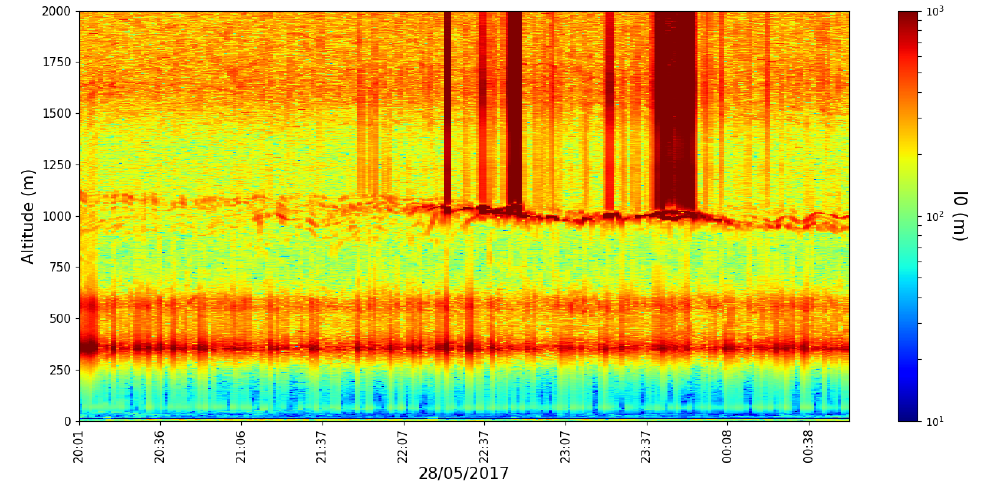
Figure 17. 𝑙 0 profile timeseries, profiling rate 1/min, 17 April 2017. Figure 17. l 0 profile timeseries, profiling rate 1/min, 17 April 2017.